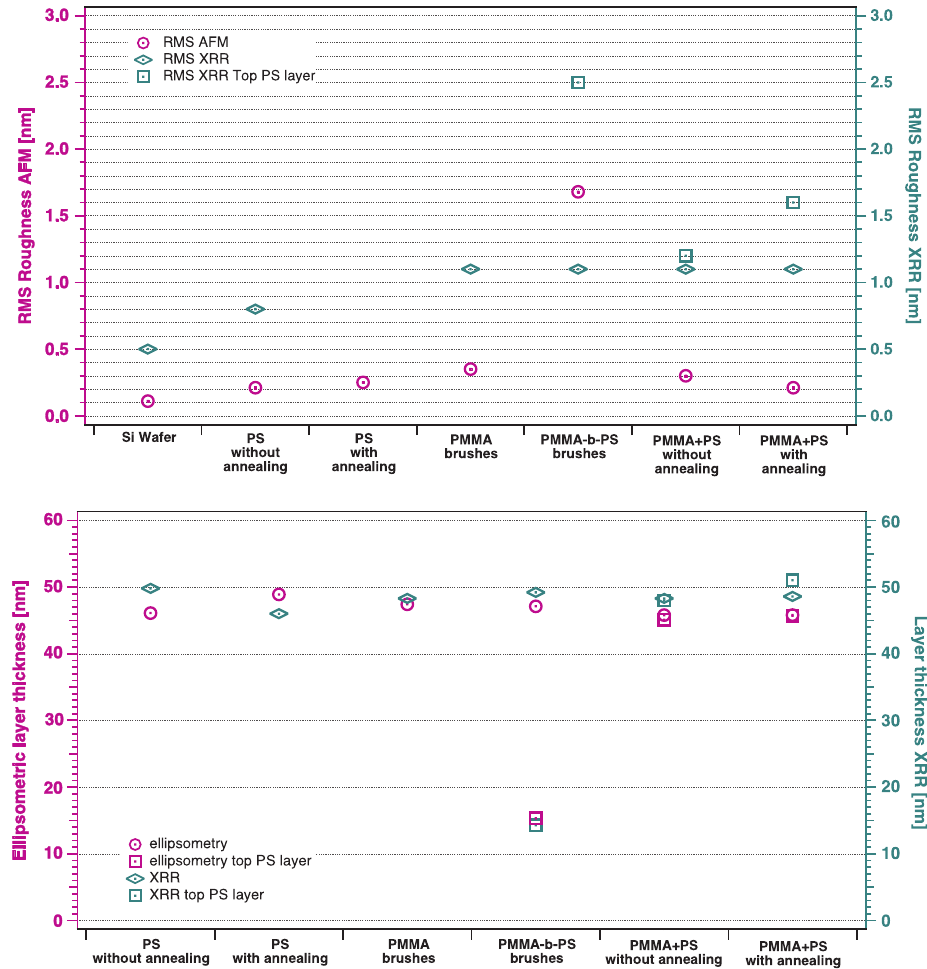
Figure 10. Comparison of layer thickness and RMS roughness results of all samples, which where performed with AFM, ellipsometry and XRR measurements. Top diagram: RMS roughness of a silicon substrate and polymer thin films, measured with AFM and XRR. XRR results are significantly higher than AFM results, which is a hint for roughness correlation. Bottom diagram: Layer thicknesses of polymer thin films, measured with ellipsometry and XRR. Results of both methods are in good